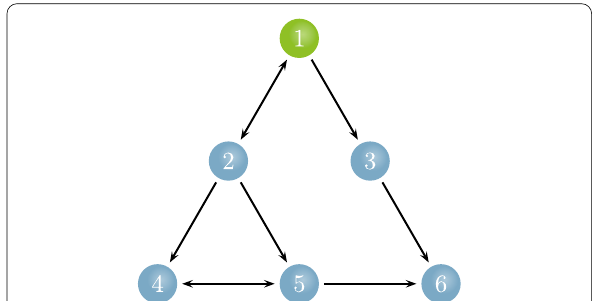
Fig. 1 Relationships of simulation data sets in the 6-node